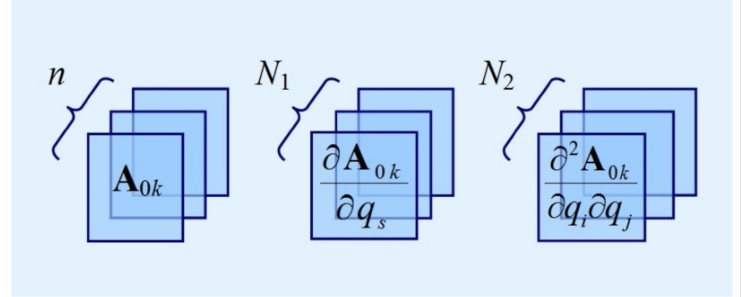
Figure 9. Geometric model. II-nd level of the